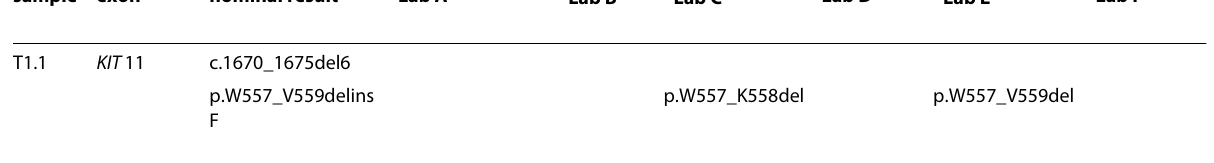
Table 1: Nominal and actual results of the mutation analyses of KIT exons 9 and 11 and PDGFRA exon 18 performed in trial 1. sample